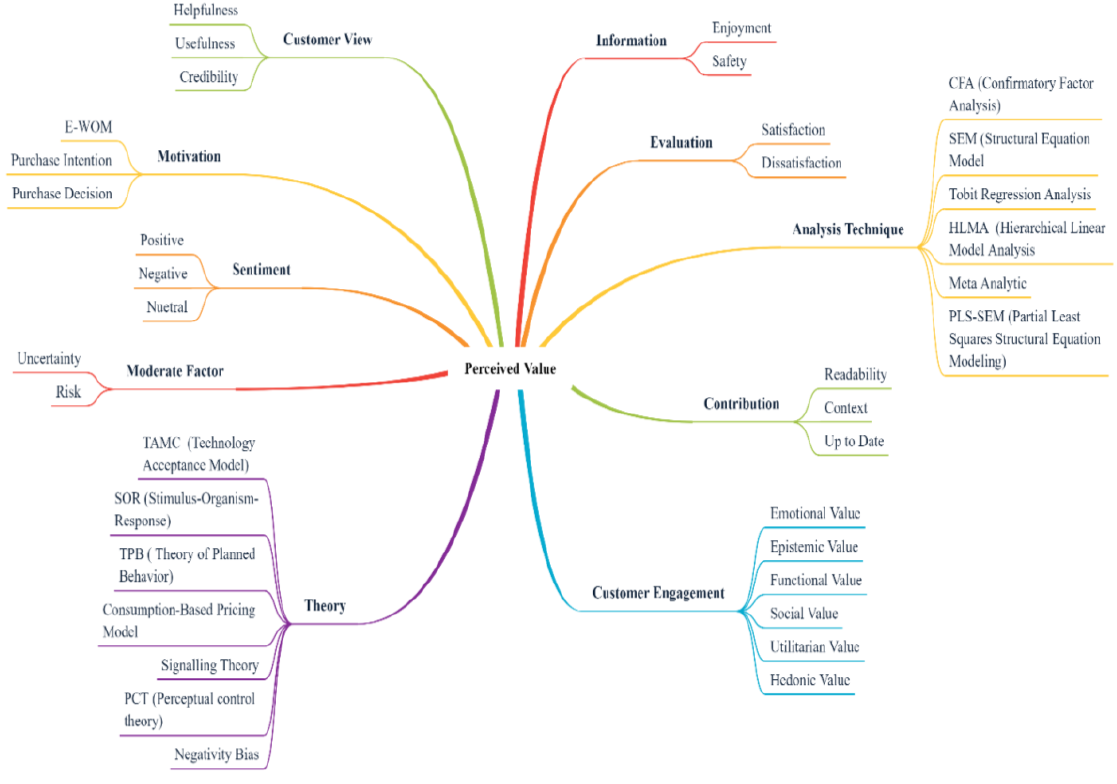
Figure 5: Mind map of perceived value’s